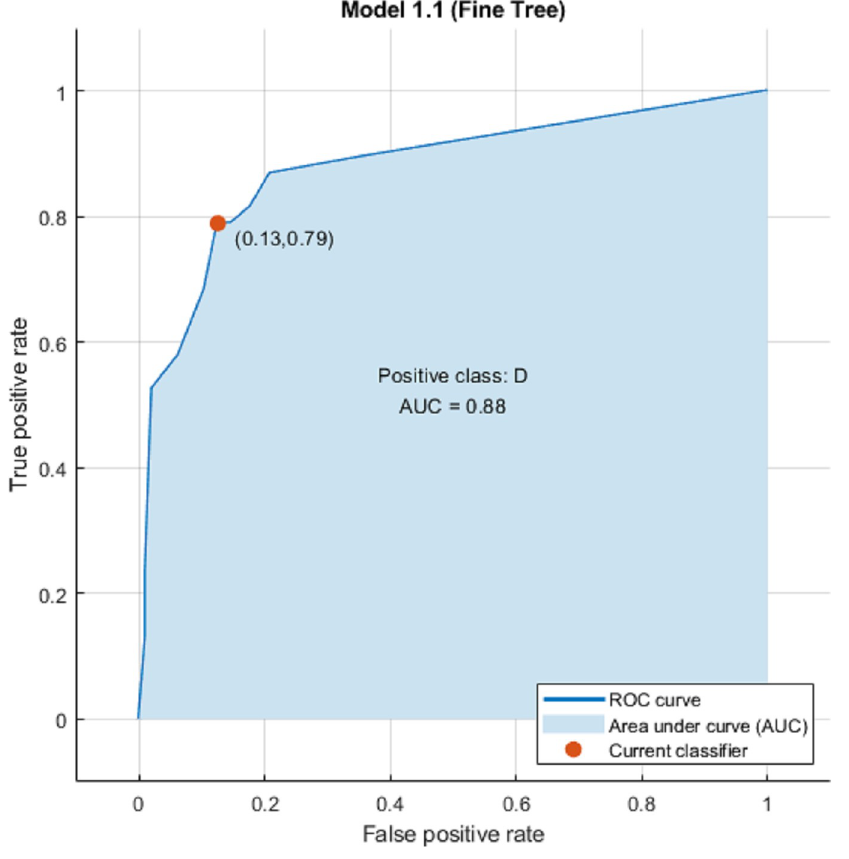
Fig 4. Fine tree model